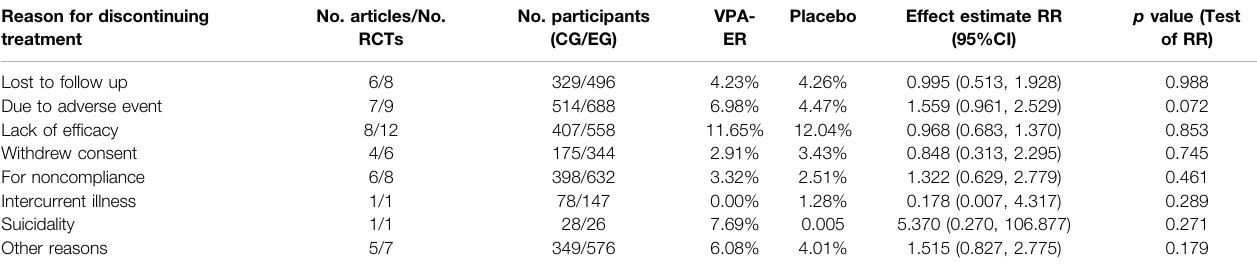
TABLE 5 | Reason for discontinuing treatment (VPA-ER vs.